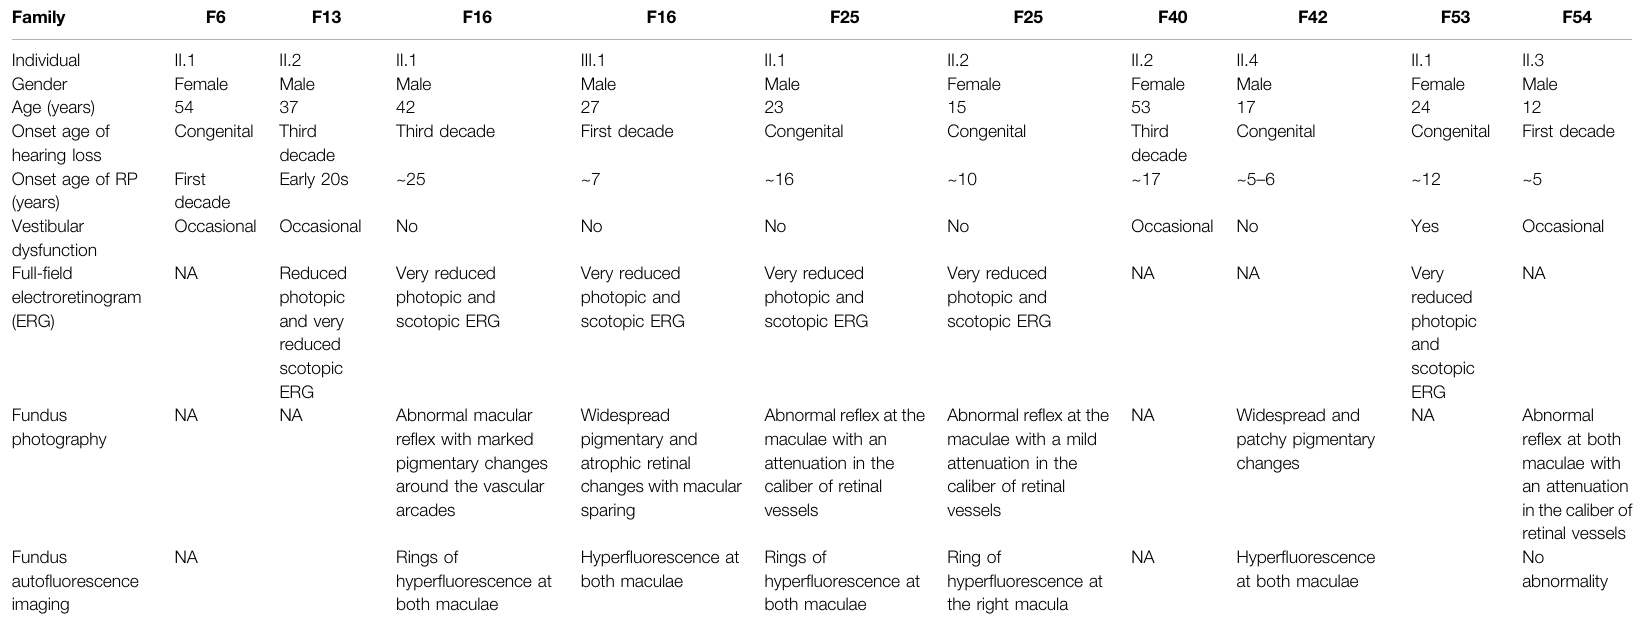
F signi fi es family. NA signi fi es not